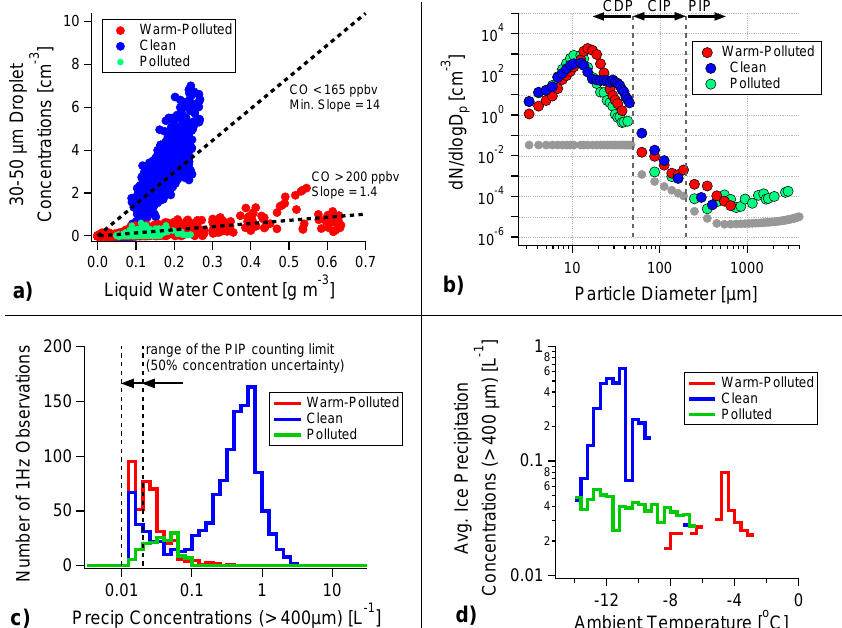
Fig. 6. Observations of cloud microphysical properties for the three different cases on the 19 April 2008 flight. (a) Number concentrations of large droplets (30–50µm) as a function of LWC. (b) Examples of measured 1Hz cloud particle size distributions at cloud top. The minimum concentration observable by each instrument is denoted by grey markers. (c) Frequency distributions of 1Hz ice precipitation number concentrations (on a log scale). (d) Average ice crystal number concentrations as a function of local ambient temperature (not necessarily the temperature at which the ice